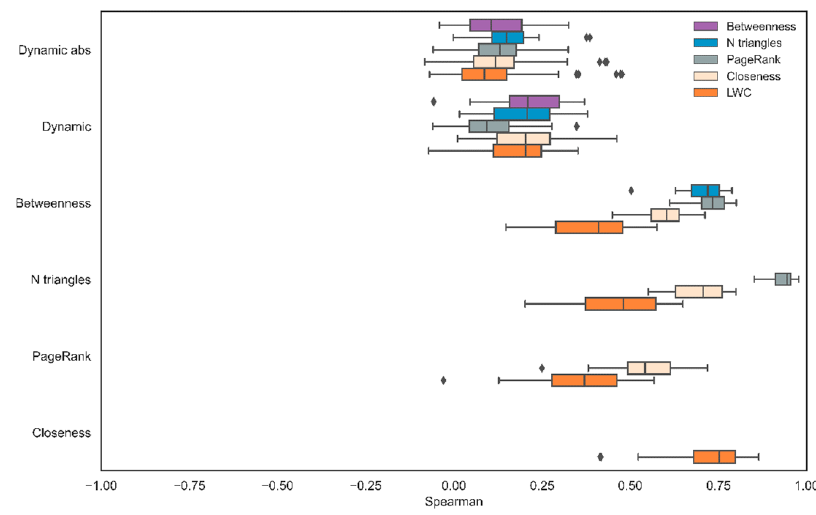
Figure 5. Spearman correlations between object-based dynamic and centrality measures. “Dynamic” denotes the directed approach, and “Dynamic abs” denotes the undirected